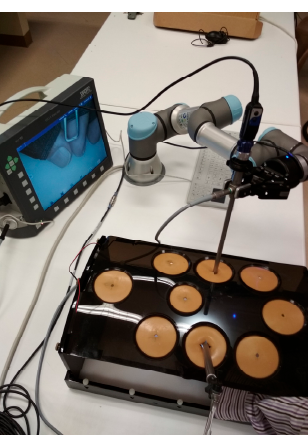
Figure 10. Scenario of experiments with a pelvitrainer, which simulates the patient’s abdomen. The collaborative robot is holding the endoscope. The sensing glove is partially viewed on the screen.